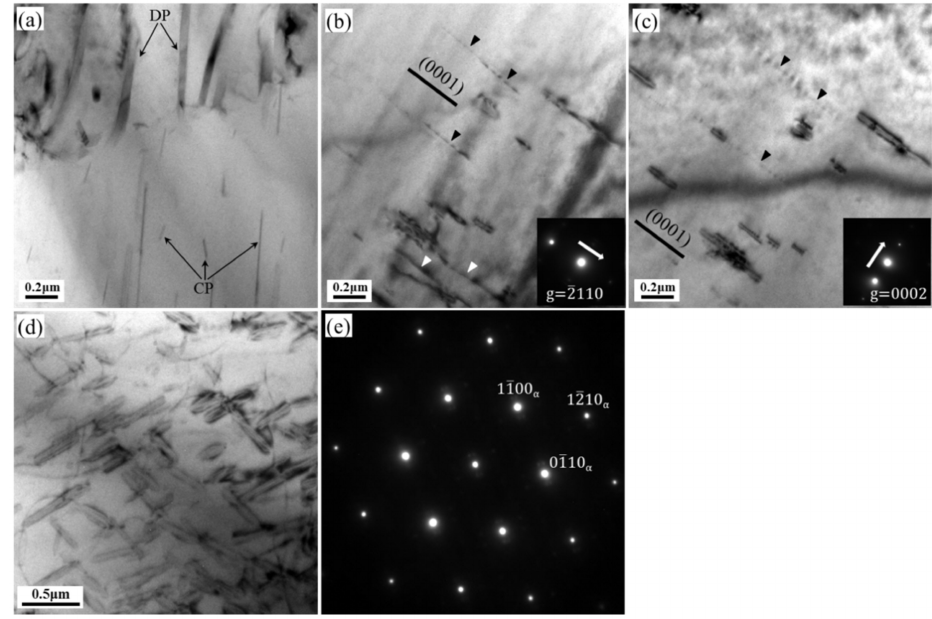
Figure 7. TEM images of HRRed specimens crept at ( a – c ) 150 ◦ C / 80 MPa and ( d , e ) 150 ◦ C / 90 MPa to 100 h. ( b , c ) are observed under two-beam conditions of g = 2 110 and g = 0002 respectively. ( e ) is the di ff raction pattern (B (cid:107) [0001] α ) for ( d ). The traces of basal planes are indicated by black